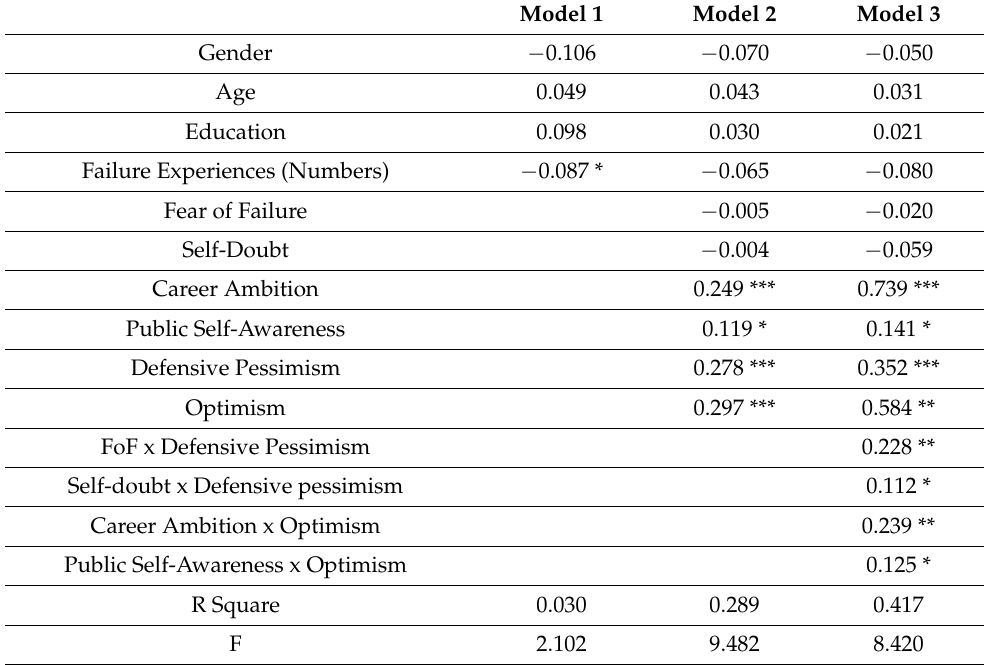
Table A5. Hierarchical regression results (dependent variable: re-entry